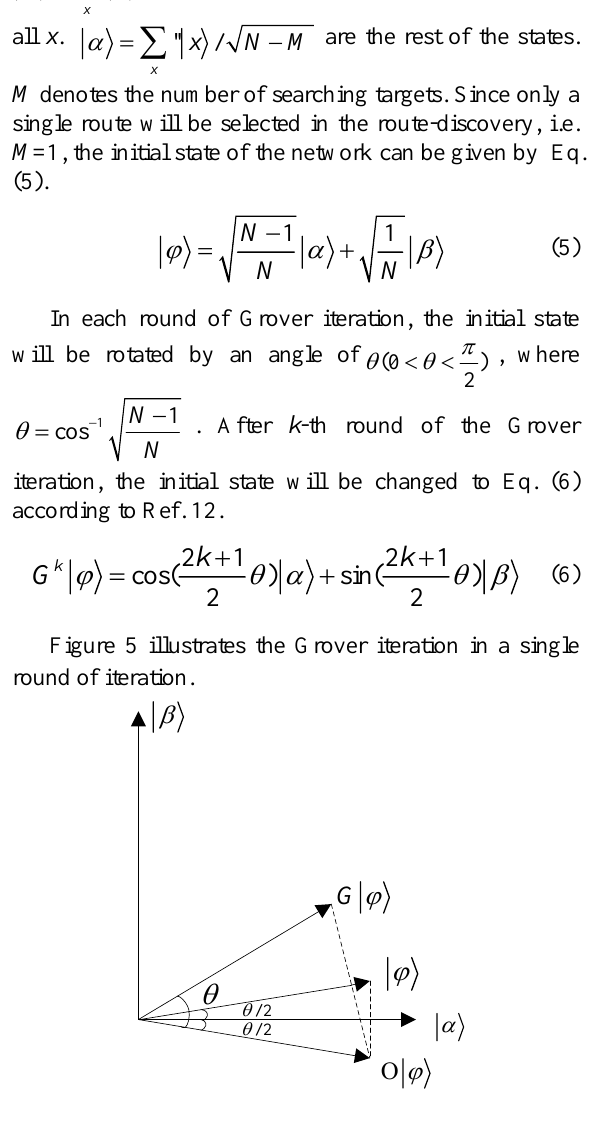
Fig. 5. Geometric view of Grover iteration in a single round When the initial state vector approaches to β after several rounds of Grover iteration, we can measure the exact probability of the searching targets. According to Ref.13, the earliest time to reach the